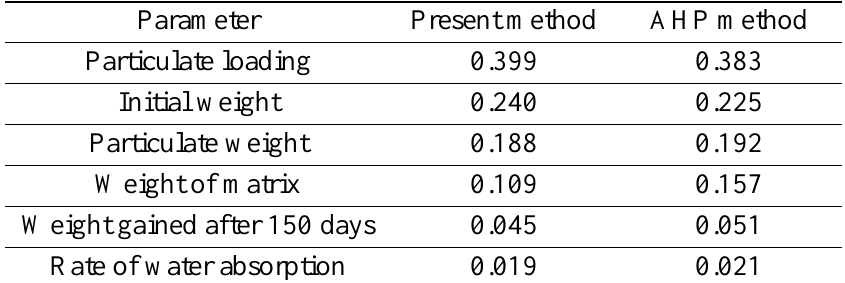
Table 12. Normalised weight values for the current method and analytic hierarchy process (AHP)